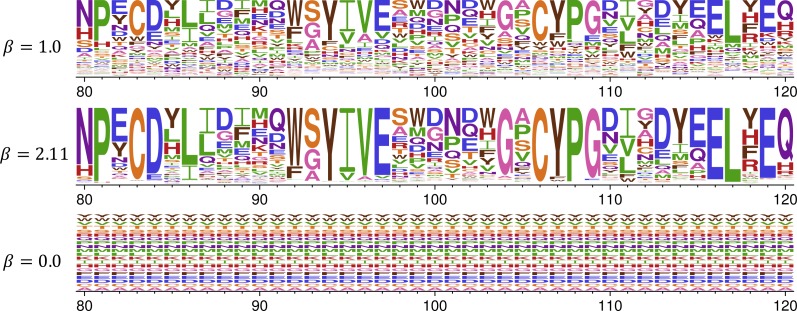
Re-scaling of amino-acid preferences to reflect the stringency of selection in nature.Analysis with phydms optimizes a stringency parameter β that relates the stringency of selection for preferred amino acids in the deep mutational scanning experiment to that in nature. When β = 1, the favored amino-acids are preferred in nature with the same stringency as during the experimental selections in the lab. When β > 1, selection in nature prefers the same amino acids as selection in lab but with greater stringency. When β < 1, selection in nature has less preference than the experiments for mutations favored in the lab, and when β = 0 then all site-specific information is lost. The actual optimized stringency parameter for HA reported in Table 2 is β = 2.11. We generated the logoplots shown above from the input data in File S3 with the following commands: phydms_logoplot HA_Doud_1.pdf –prefs HA_Doud_prefs_short.csv
phydms_logoplot HA_Doud_2_11.pdf –prefs HA_Doud_prefs_short.csv –stringency 2.11
phydms_logoplot HA_Doud_0.pdf –prefs HA_Doud_prefs_short.csv –stringency 0.